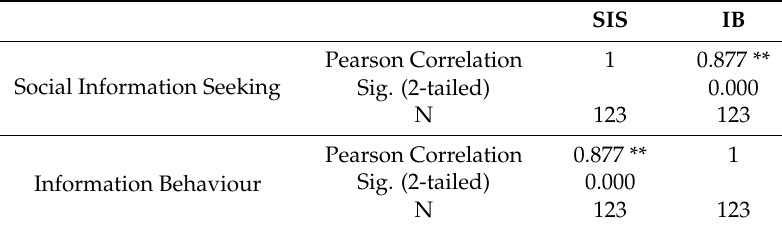
Table 2. Pearson product-moment correlation coefficient result.